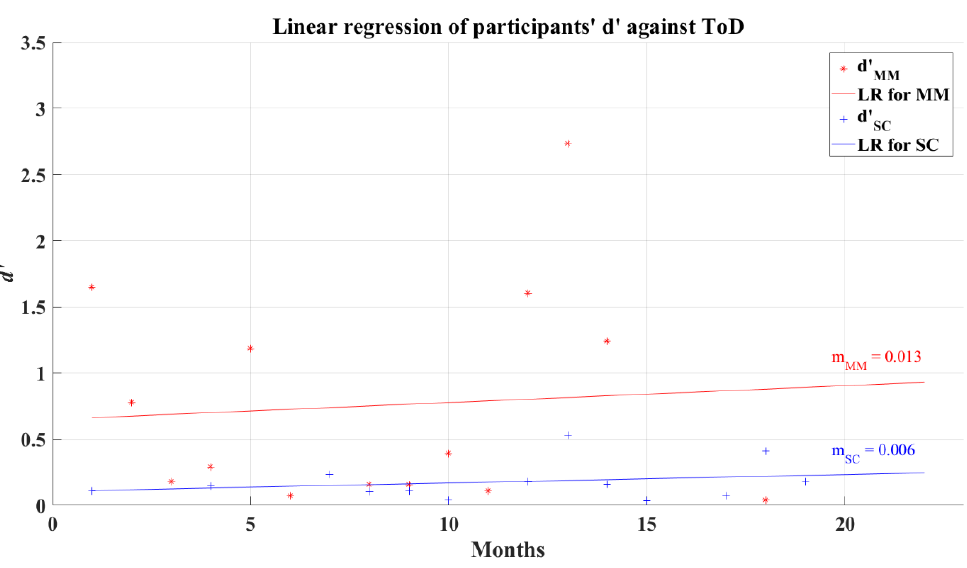
Figure 12. Cognitive metrics for 2AFC-P2 by group. Red line—median value of Focus, Interest, and Engagement for the corresponding group; red plus sign (+)—Outliers for the corresponding performance metric. 3.4. Simple Reaction Time Analysis The reaction times show an increasing pattern between groups, SC group presented the slowest reaction time ( M = 367.75 ms, SD = 68.679 ms, Mdn = 360.146 ms), as can be